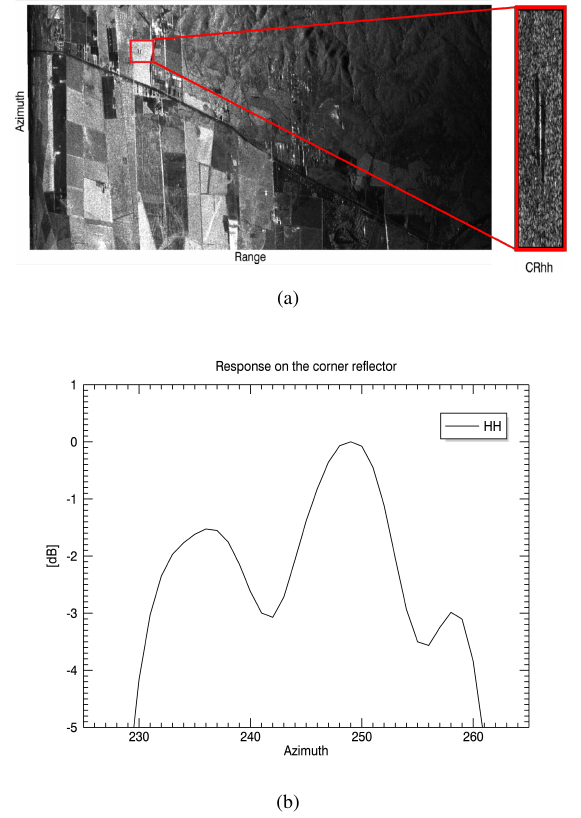
Figure 3. Broadening effect observed in the SLC relevant to track 19. a) SLC amplitude image (HH polarization) relevant to track 19. Red rectangles highlight the region surrounding the corner reflector. b) Azimuth cut of the SAR response over the corner reflector.